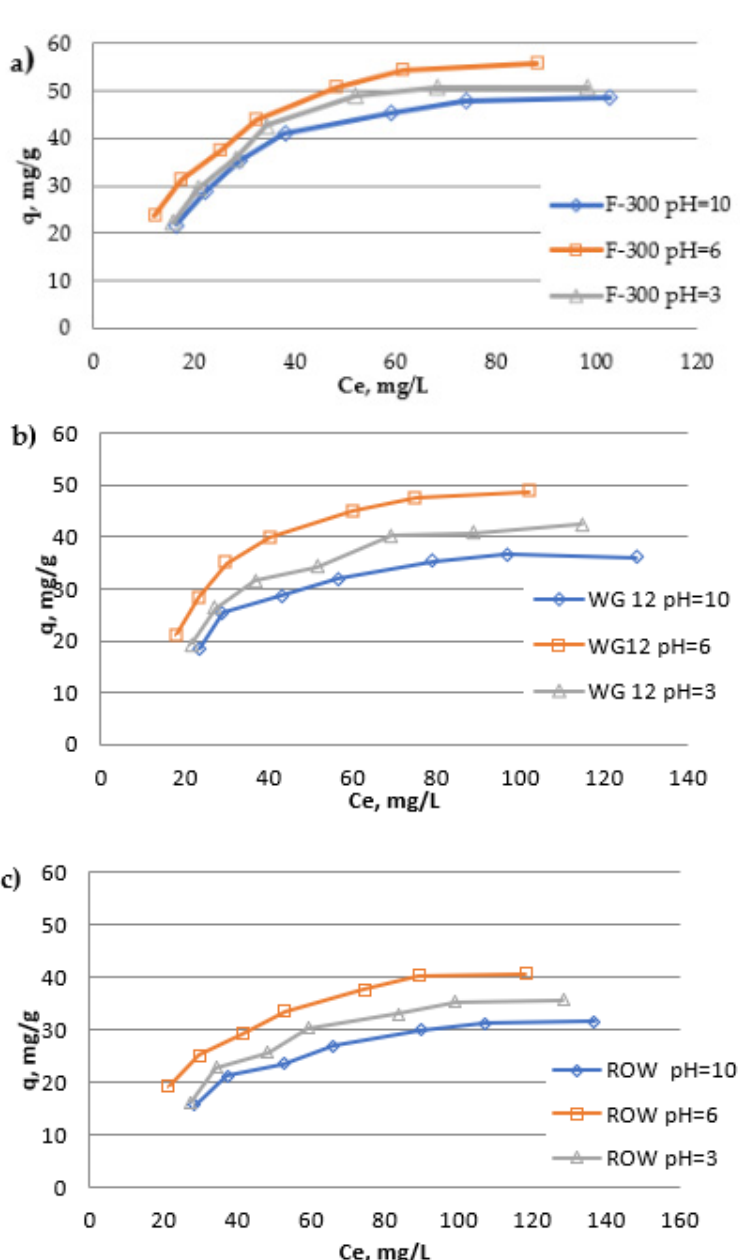
Figure 7. Oxytetracycline adsorption isotherms on activated carbons from solutions of different pH: ( a ) ROW 08 Supra; ( b ) WG-12; ( c ) F-300.